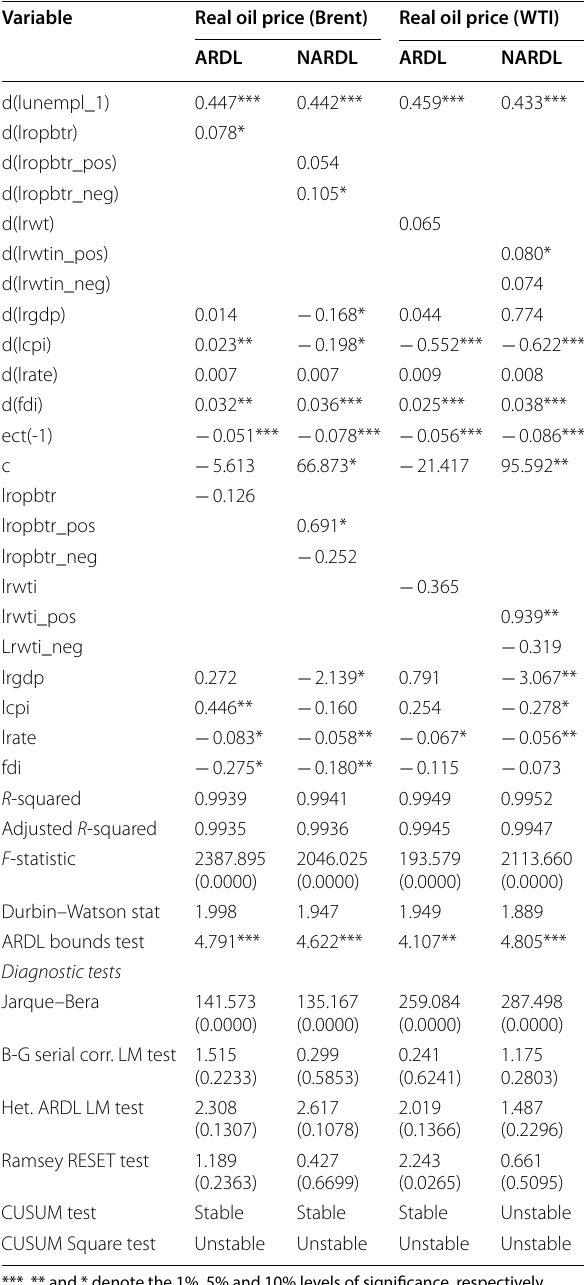
Table 4 Linear and nonlinear ARDL models of unemployment effect of oil price change